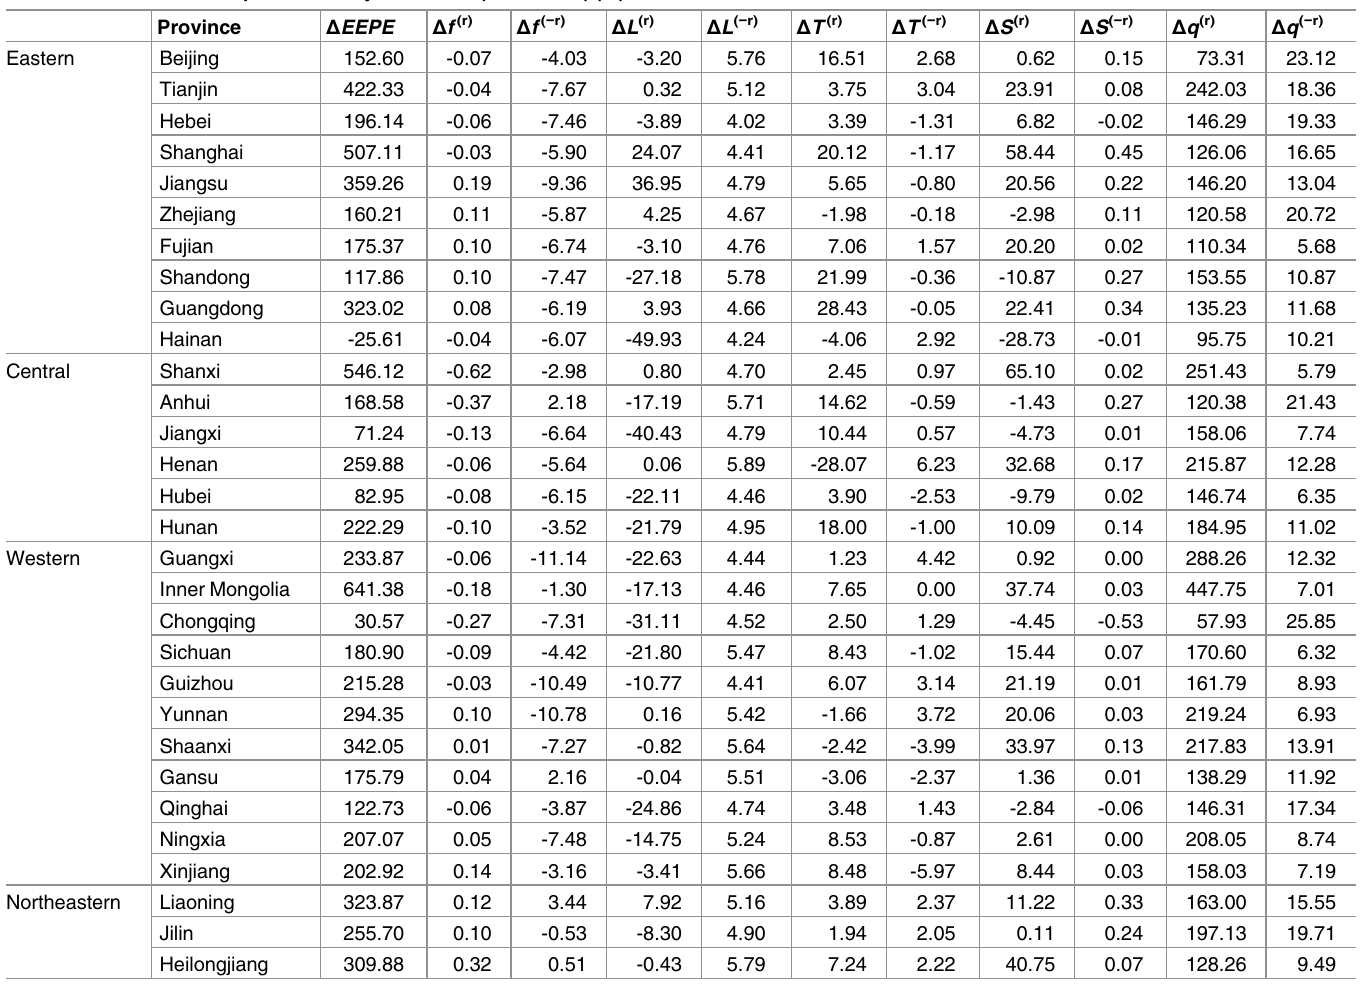
Table 3. Structure decomposition analysis of EEPI (2002–2010)